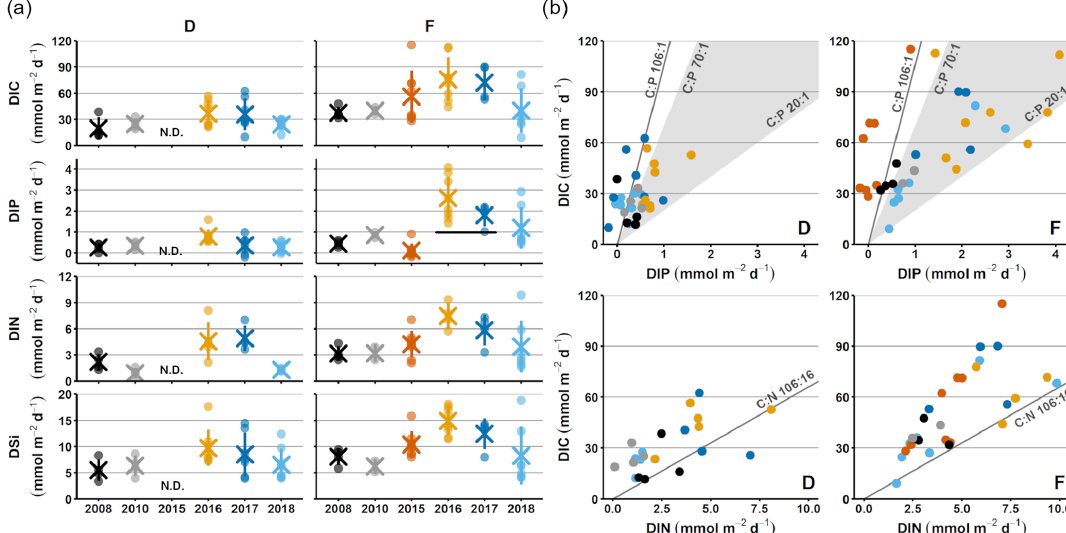
Figure 2. Sediment–water fluxes measured with the benthic chamber lander. Flux data are from before the inflow (2008, 2010; Hall et al., 2017; Nilsson et al., 2019; Viktorsson et al., 2013), right after the inflow (2015; Hall et al., 2017), and post-inflow (2016–2018; this study). (a) Changes in fluxes with time. Small circles mark individual chamber measurements, crosses mark station averages, and lines represent station standard deviations. The black line in the DIP graph for station F in 2016–2017 marks the expected flux for those years, based on the decrease in solid phase inventory. N.D. stands for no data. (b) Fluxes of DIC vs. DIP and DIN. The grey line represents the Redfield ratios of 106:1 for DIC:DIP and 106:16 for DIC:DIN, the shaded area marks the DIC:DIP ratios between 20:1 and 70:1. Colour-coding is the same as in (a)